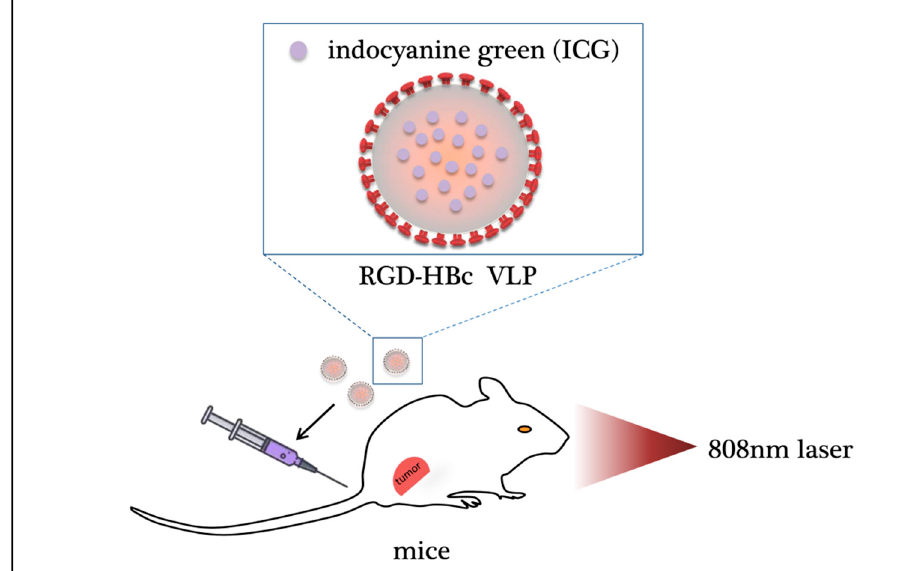
Figure 3. Photodynamic effect of virus nanoparticles carrying antitumor drugs. By regulating the self-assembly process of protein-like virus particles (VLPs), the fluorescent dye ICG can be loaded into a positively charged cavity to prepare RGD-HBc/ICG VLPs, thereby improving the stability of ICG, extending its circulation time in the body and effectively delivering it to the tumor. Under 808 nm near-infrared laser irradiation, RGD-HBc/ICGVLPs can produce photothermal/photodynamic effects and significantly eliminate tumor tissue in mice. ICG: indocyanine green; HBc VLP: hepatitis B core protein virus-like particle; RGD: tripeptide Arg ‐ Gly ‐ Asp.